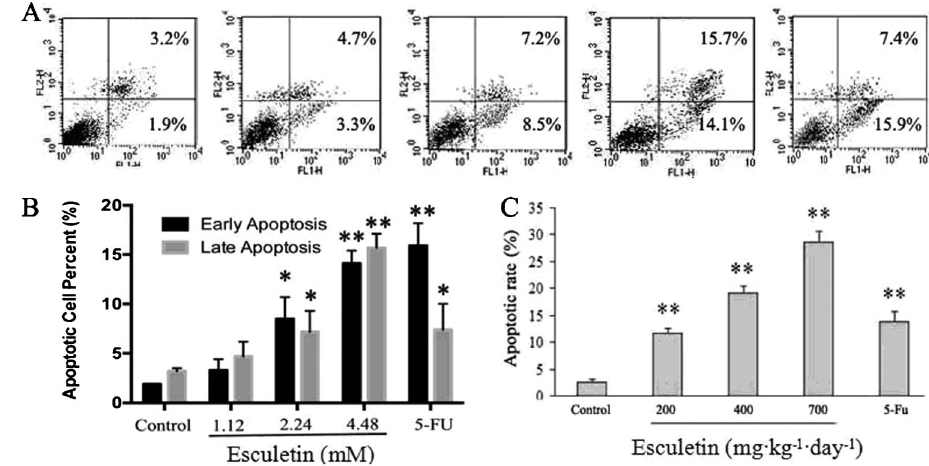
Figure 3. Esculetin induced apoptosis of hepatocellular carcinoma (HCC). SMMC-7721 cells were grouped and harvested after esculetin (0, 1.12, 2.24, and 4.48 mM) and 5-FU (0.77 mM) treatment for 48 h ( A and B ). Early and late apoptosis of HCC cells was determined by flow cytometry analysis using a PI-Annexin V-FITC kit. Data were analyzed using Bioconsort software and are reported as means±SD. In addition, apoptotic cells ( C ) in tumors were also detected and analyzed using the Bioconsort software and are reported as means±SD for n=15. **P , 0.01 vs control group (one-way ANOVA followed by Bonferroni’s